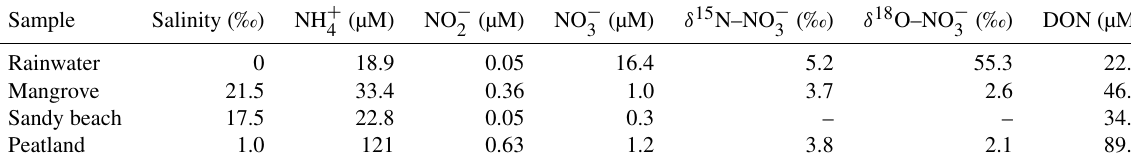
Figure 5. Distribution of the NO − the salinity gradient from three cruises; distribution of the δ 15 N–NO − the salinity gradient in 2017; comparison between the δ 15 N/ 18 O–NO − correlation between δ 15 N–NO − 0.99 ( R 2 : 0.64).